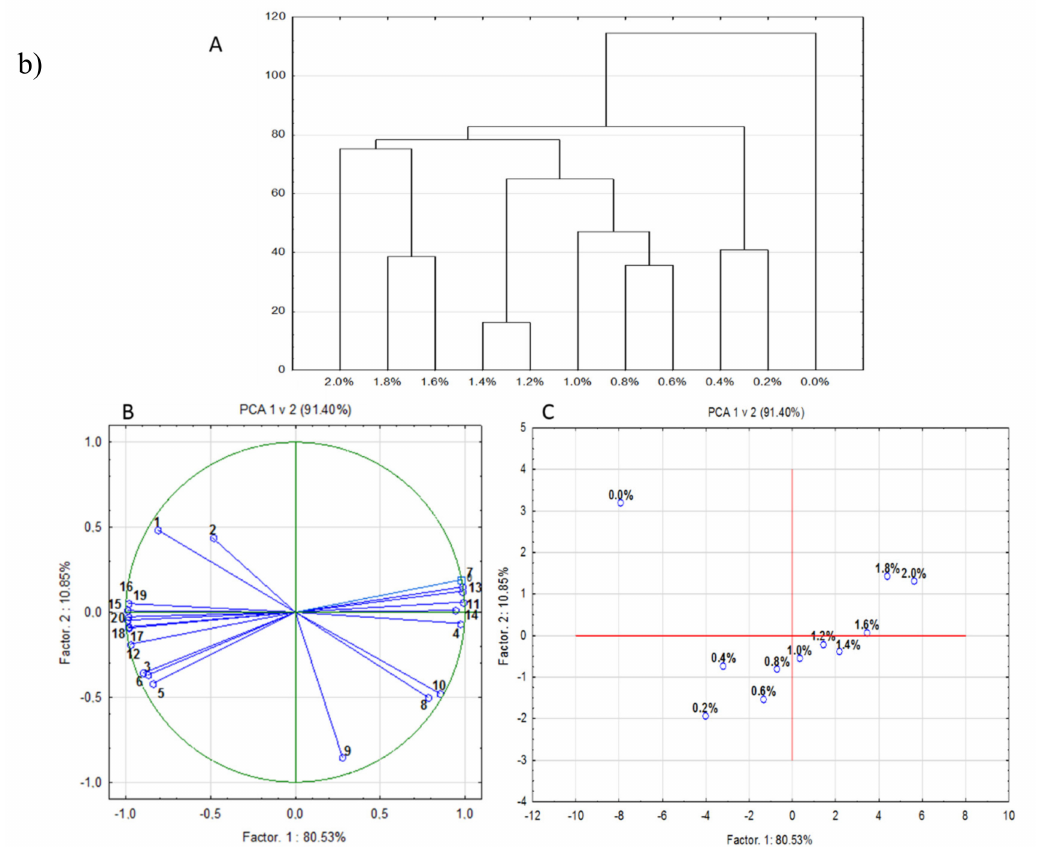
Figure 8. The statistical analysis for chokeberry fruit ( a ) and for cranberry fruit ( b ): ( A ) dendrogram, ( B ) decomposition of measured parameters (1-ABTS; 2-FRAP; 3-Color; 4-Taste; 5-Aroma; 6-Turbidity; 7-Calcium; 8-Magnesium; 9-Potasium; 10-Phosphorus; 11-Ash; 12-Acidity; 13-pH; 14-L*; 15-a*; 16-b*; 17-Anthocyanins; 18-Phenolic acids; 19-Flavonoids; 20-Sum of polyphenolic compounds), ( C ) decomposition of measured samples (from 0.0% to 2.0% of